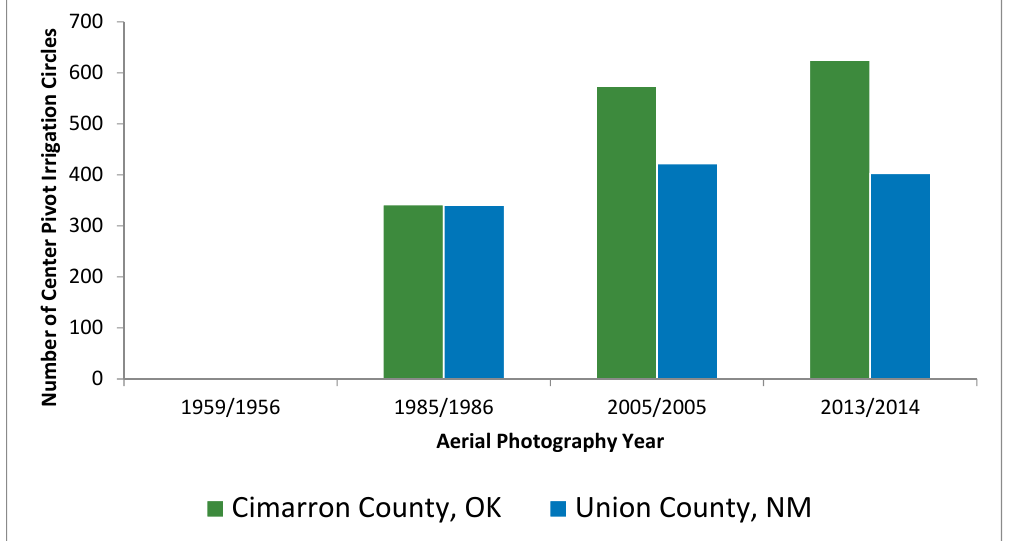
Figure 3. Number of center pivot irrigation circles within Cimarron County, OK and Union County NM, respectively, 1956–2014.